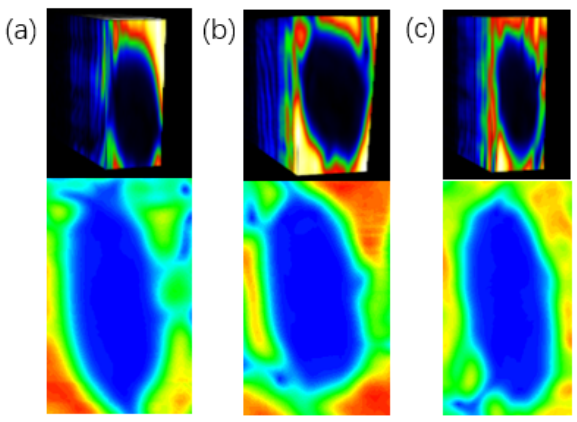
Figure 4. Original terahertz spectral image of wheat. ( a ) Normal wheat; ( b ) moldy wheat; ( c ) Figure 4. Originalterahertzspectralimageofwheat. ( a )Normalwheat; ( b )moldywheat; ( c sprouted wheat.